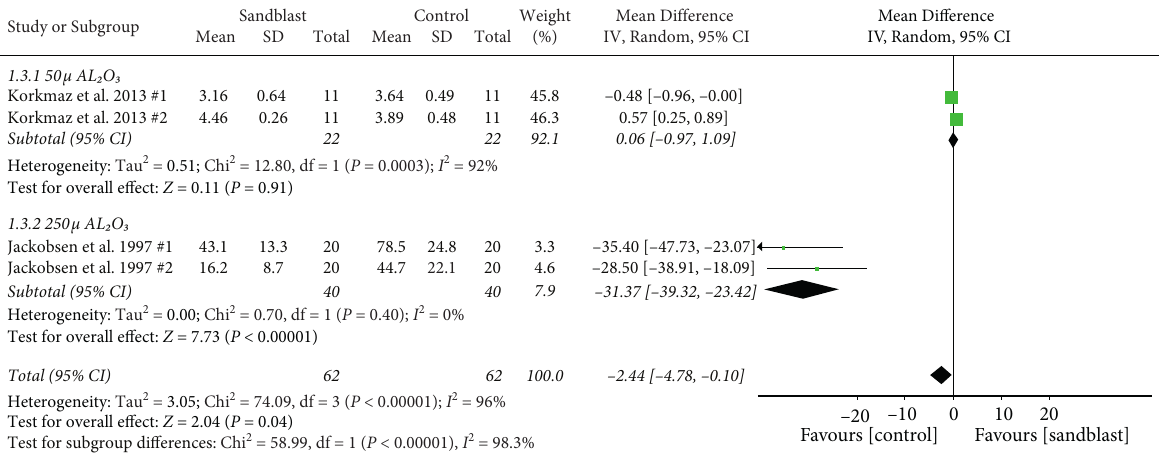
Figure 7: Forest plot for subgroup analysis of particle size for peel bond strength.